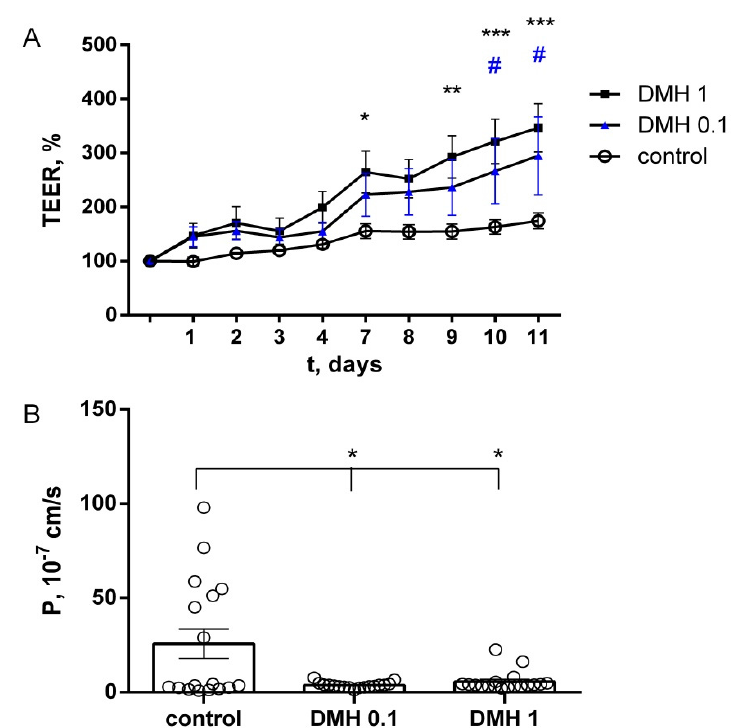
Figure 3. Cell monolayers. ( A ) transepithelial electrical resistance (TEER). * p DMH 1 < 0.05, ** p DMH 1 < 0.01, *** p DMH 1 < 0.001, # p DMH 0.1 < 0.05 compared with the control group, two-way ANOVA (n each group = 6). ( B ) permeability for fluorescein of the IPEC-J2 cell monolayers. * p < 0.05, paired t -test (n measurements for each group = 18.